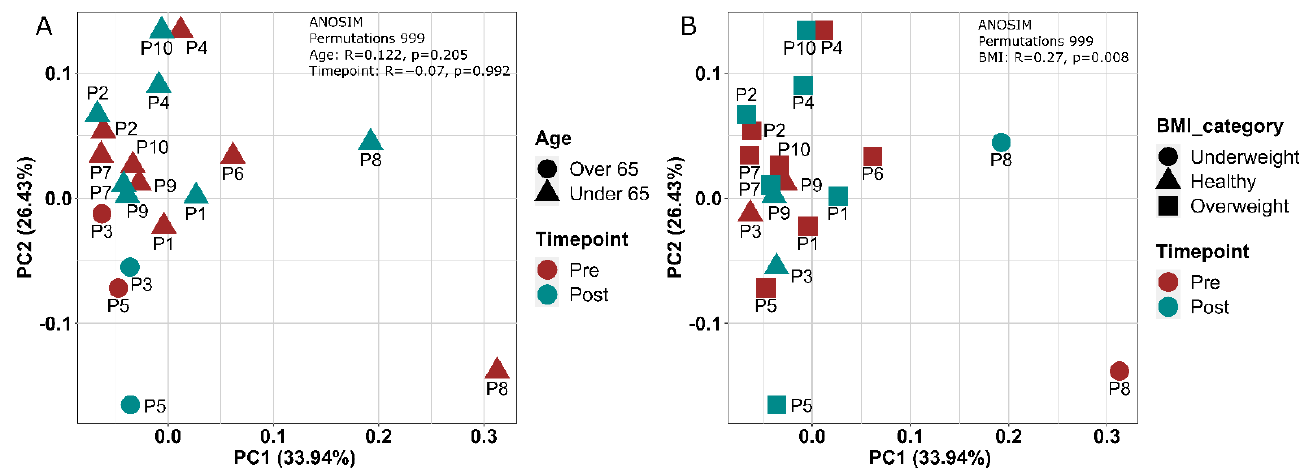
Figure 4. Gut microbiota beta diversity analyses for Alberta Cancer Exercise (ACE) participants. Beta diversity was measured by Weighted UniFrac Distance Matrix-based PCoA for pre- (baseline) and post- (12 weeks) exercise in the ACE program and analyzed with ANOSIM. Age (over or under 65) and time point did not significantly influence community diversity ( A ). Body mass index (BMI) category significantly influenced community diversity ( p = 0.008) ( B ).